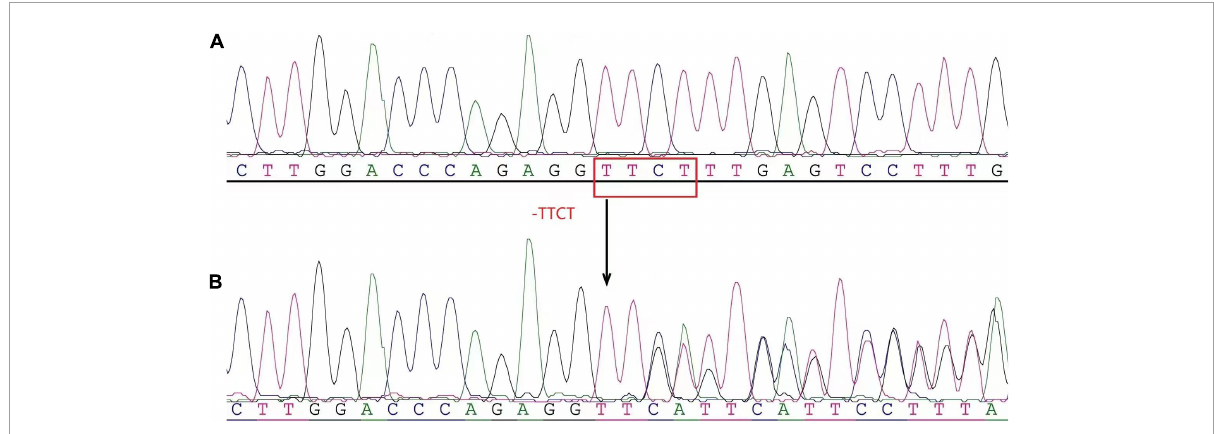
FIGURE2 The heterozygosity for the 4-base deletion mutation [codons 41/42 (–ttct) bETa 0 ] of the β -globin gene ( hbb ) was determined by high-throughput gene sequencing. (A) Normal control reference sequence. (B) Patient. The arrows indicated the site of the deletion mutation of the β -globin gene.